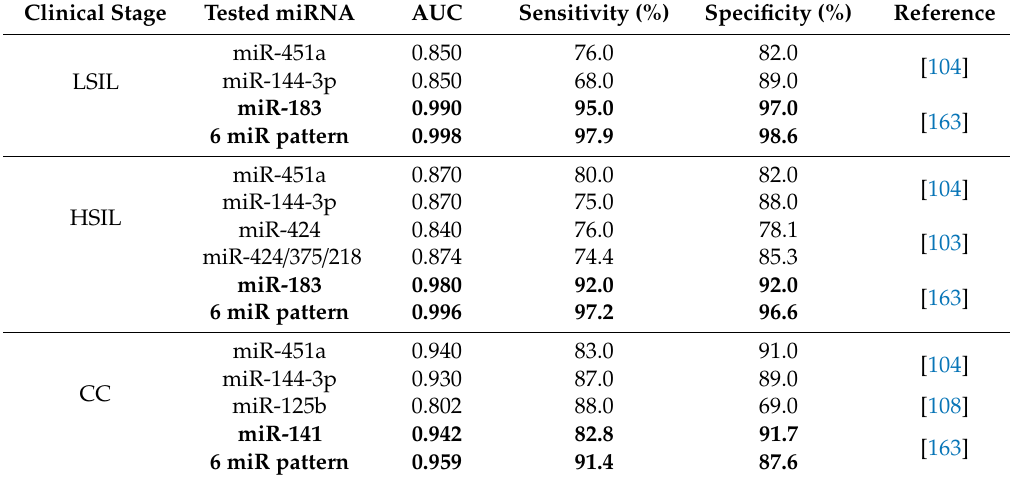
Table 4. Diagnostic accuracy of miRNA-based exfoliative cytology testing in di ff erentiating of cervical